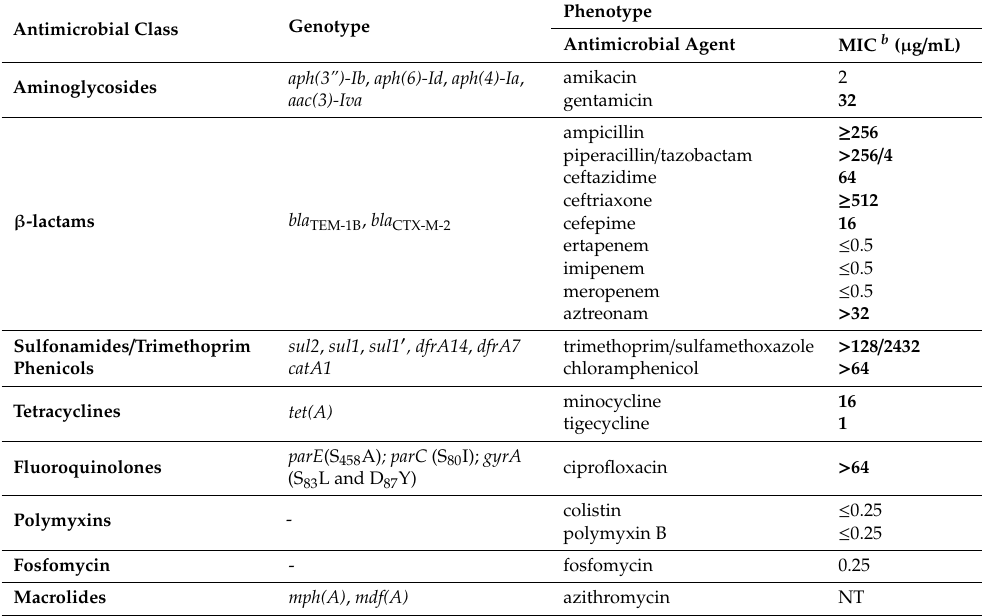
Table 4. Antimicrobial resistance genotype and phenotype observed in strain